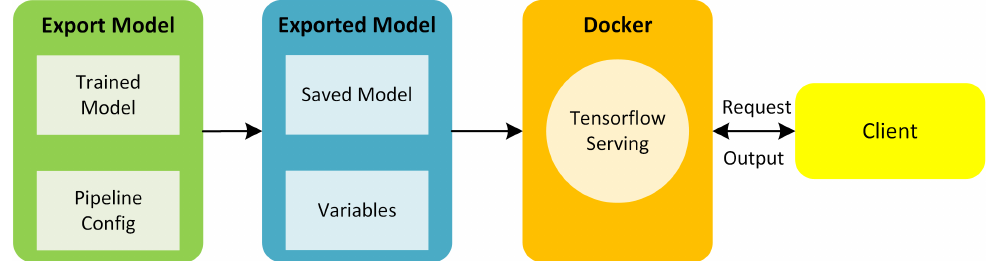
Figure 4. Process flow for PdM